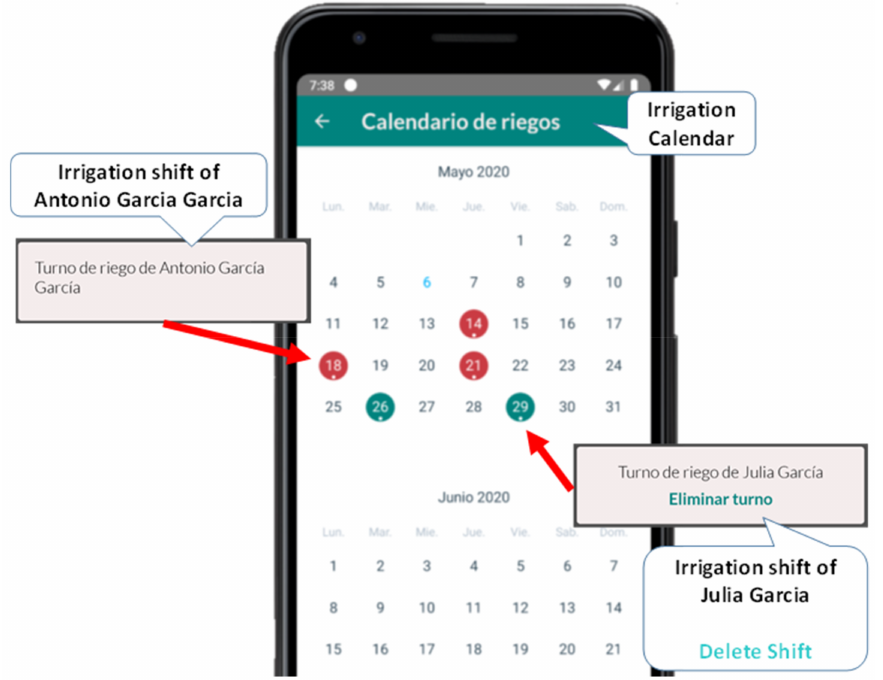
Figure 15. Screen of irrigation